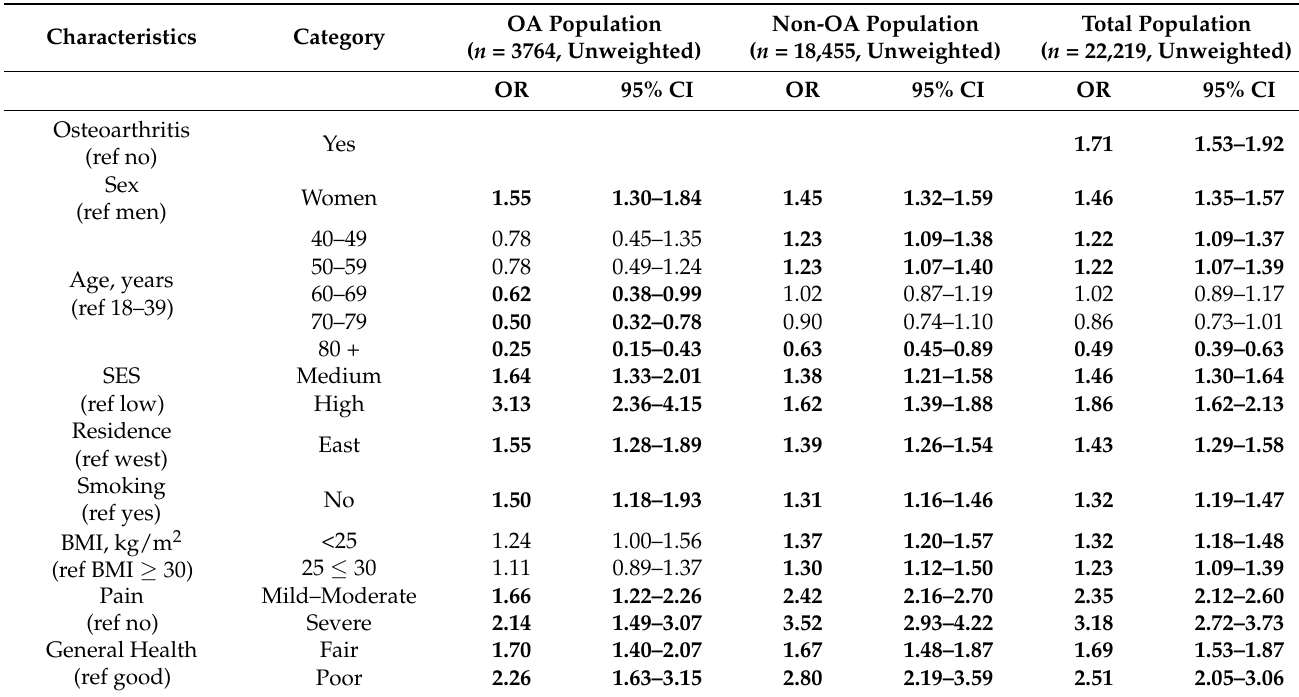
Table 3. Multivariable logistic regression analysis: associated factors for the utilization of physical therapy within OA, Non-OA and total